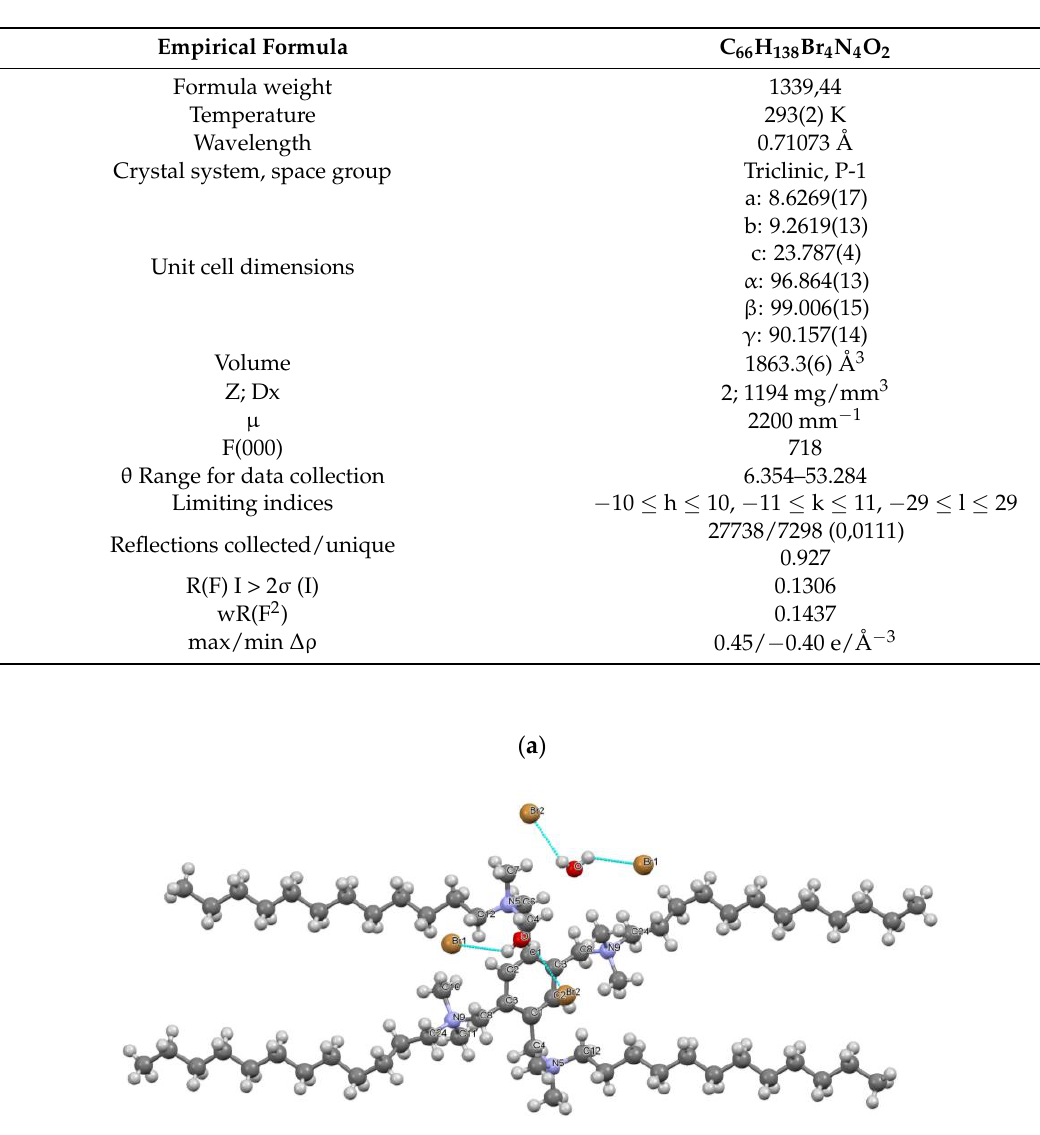
Table 2. Crystal data and structure refinement for compound 21 .